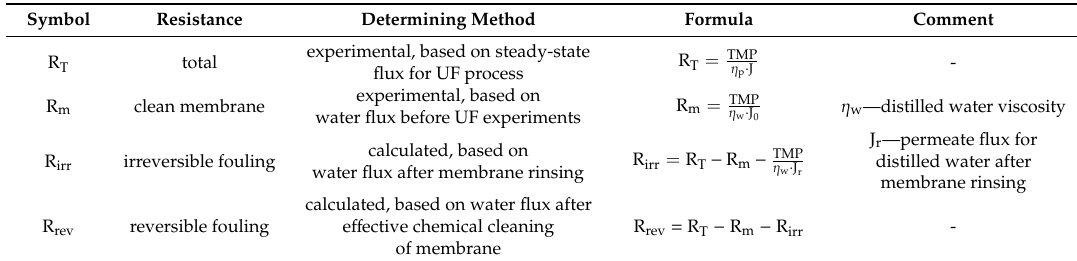
Table 2. Description of parameters in Equation